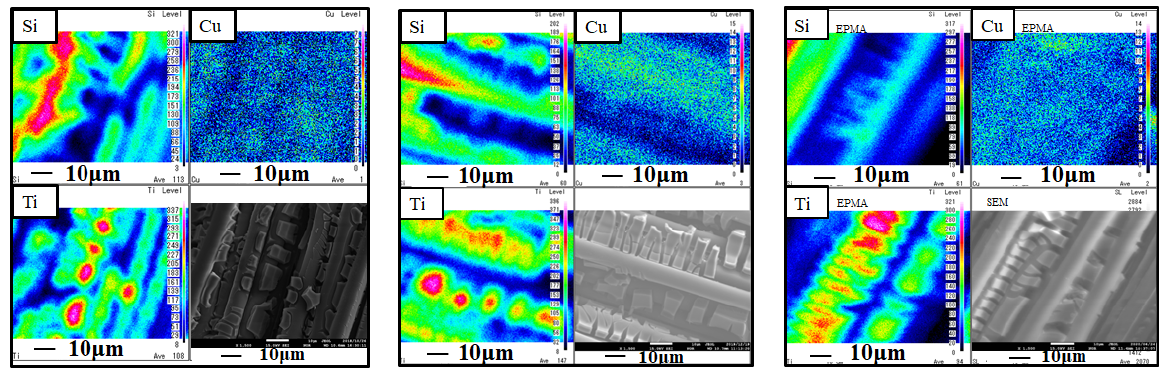
Figure 1. SEM and EPMA images of Cu/TiO 2 film which is coated on netlike glass disc. The left images show the data for the pulse number of 100, the center images show the data for the pulse number of 200, and the right images show the data for the pulse number of 500.